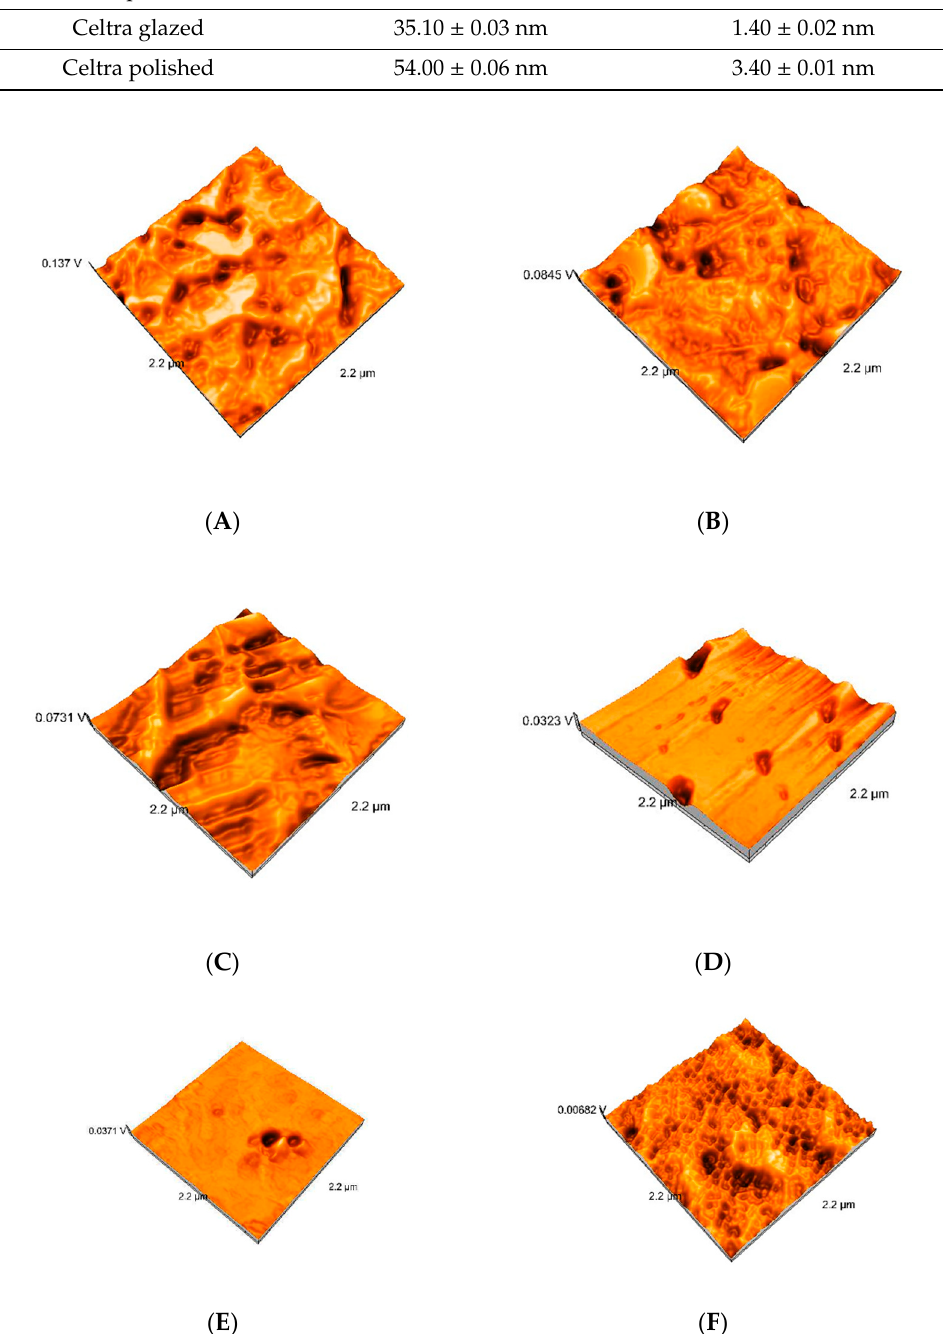
Figure 4. Atomic force microscope images of samples after thermocycling polished and glazed. ( A ) Vita polished; ( B ) Vita glazed; ( C ) Emax polished; ( D ) Emax glazed; ( E ) Celtra polished; and ( F ) Celtra